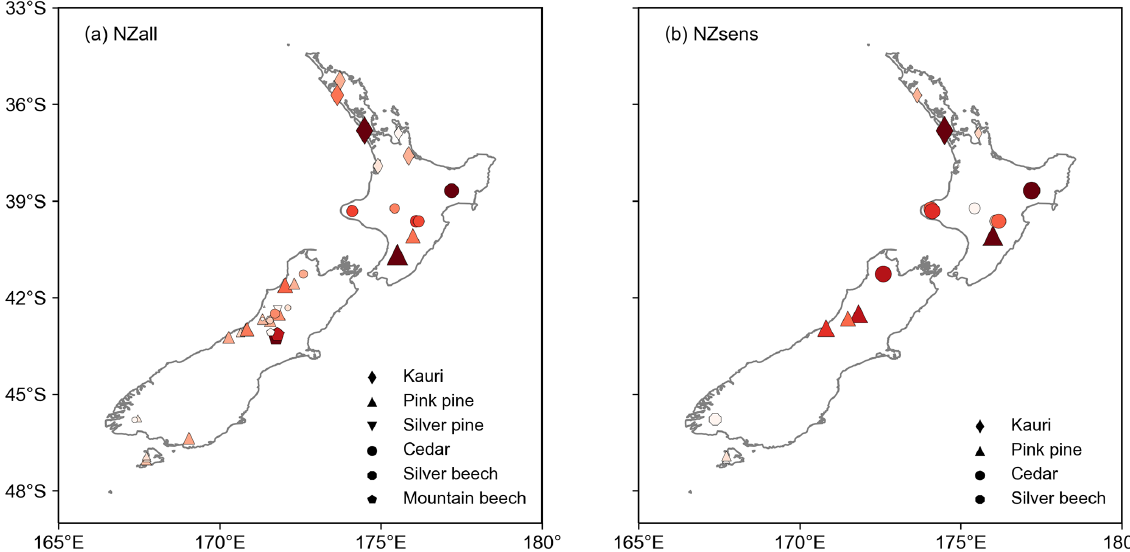
Figure 7. Distribution of tree rings used in (a) the NZall temperature reconstruction and (b) the NZsens temperature reconstruction. Larger, darker red markers represent chronologies with greater relative weighting in the multiple regression. Made with Natural Earth free vector map data available at http://naturalearthdata.com (last access: 17 November 2021).